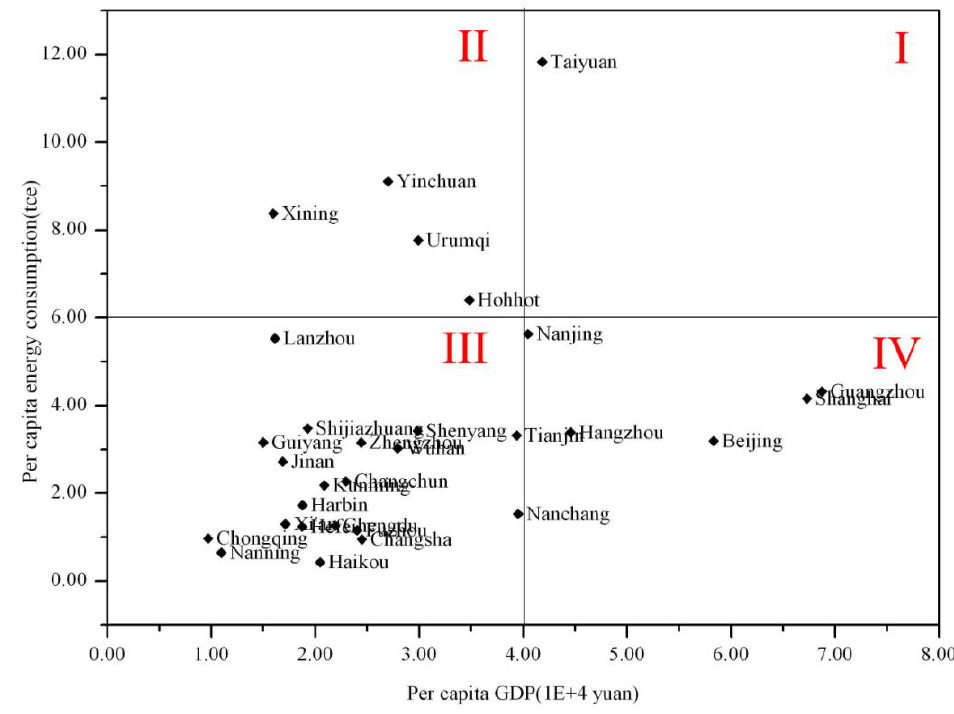
Figure 3 . Per capita energy consumption and per capita GDP in 30 case cities in China in